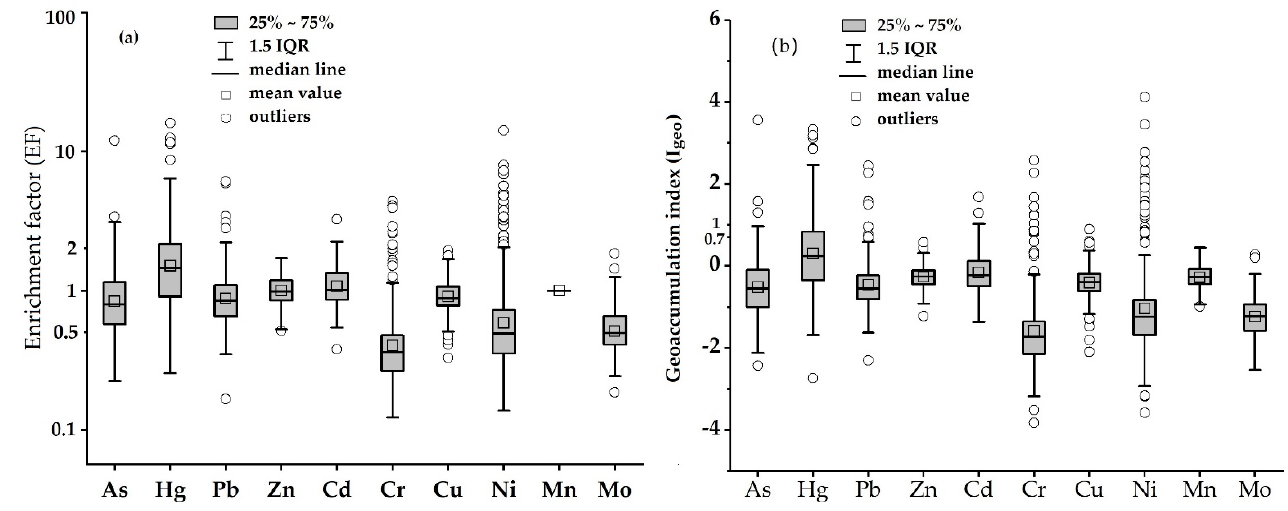
Figure 2. Box ‐ line diagram of heavy metal EFs ( a ) and I geo ( b ) . Figure 2. Box-line diagram of heavy metal EFs ( a ) and I geo ( b